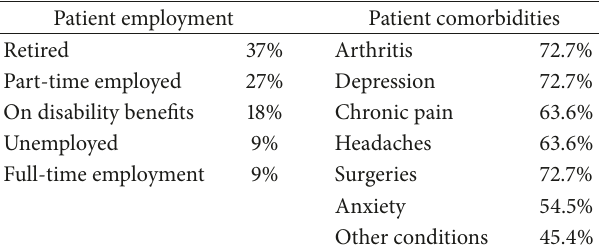
Table 3: Patient employment and